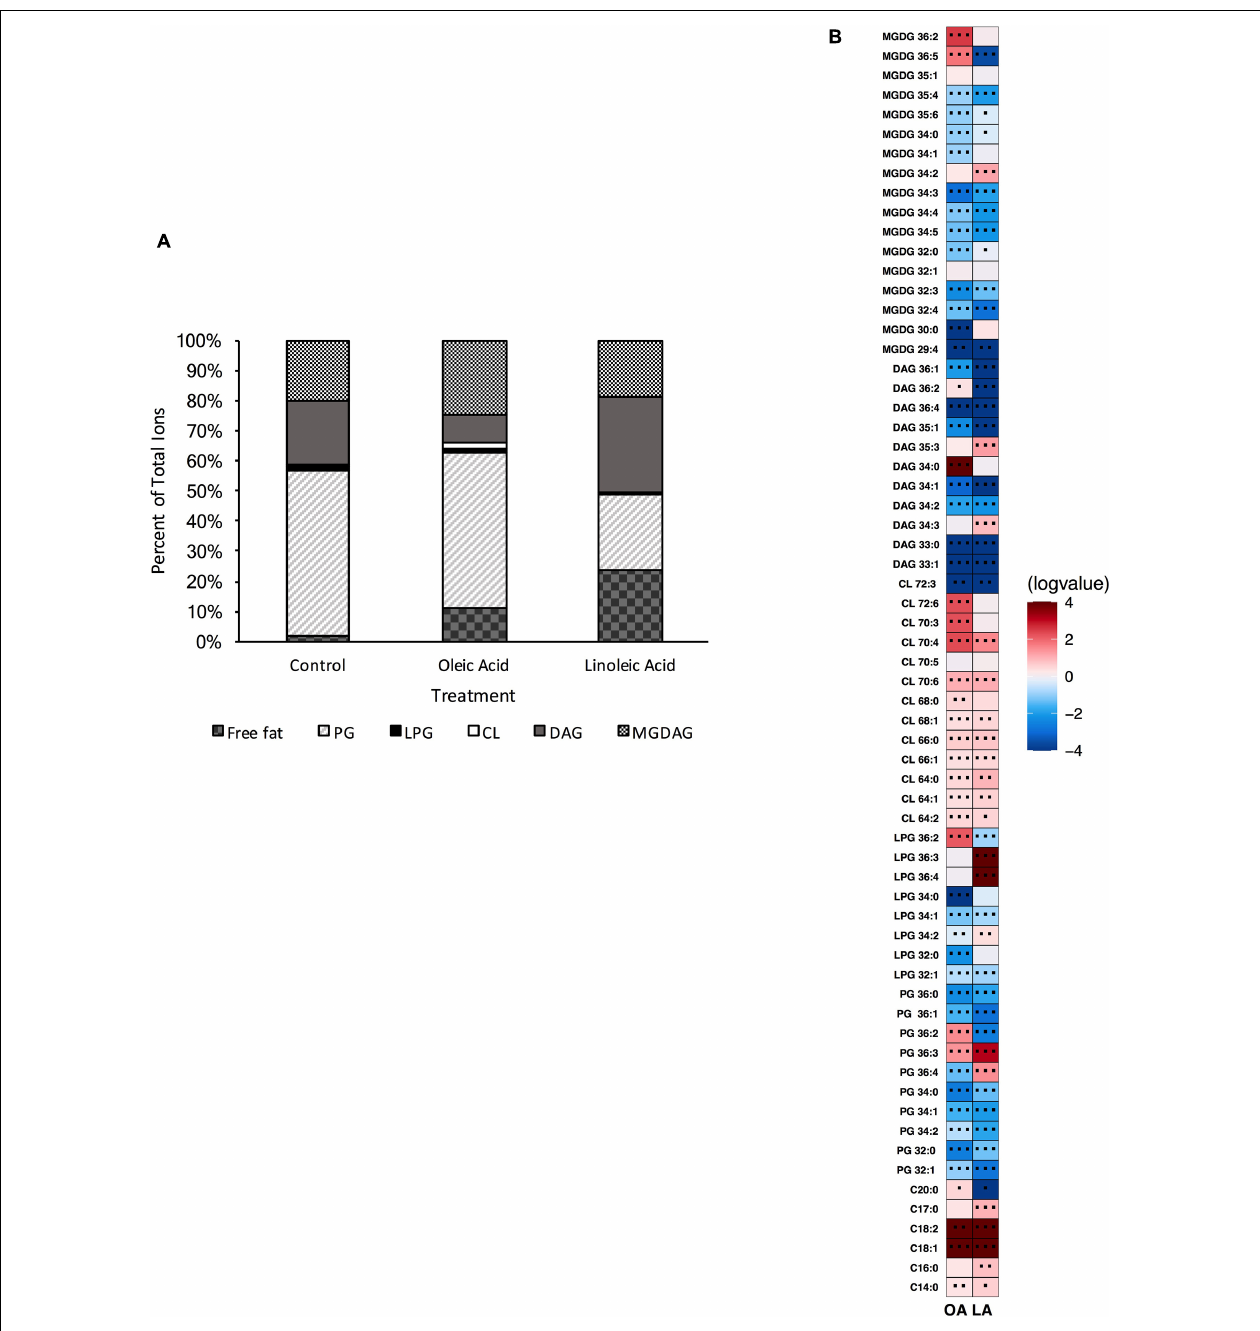
FIGURE 3 | OG1RF lacking (cid:49) cls2 can still produce cardiolipin and alter its lipid composition upon exposure to host fatty acids. (A) Percent totals of lipid species for (cid:49) cls2 in solvent control: free fatty acids (1.9%), PG (55.1%), L-PG (1.0%), CL (0.7%), DAG (21.2%), and MGDG (20.1%), oleic acid: free fatty acids (11.1%), PG (51.6%), L-PG (1.2%), CL 2.1%), DAG (9.4%), and MGDG (24.6%), linoleic acid: free fatty acids (35.5%), PG (35.5%), L-PG (1.9%), CL (2.6%), DAG (4.1%), and MGDG (20.4%). Species were normalized to OD 600 nm . (B) Heat-map of fold changes (cid:49) cls2 upon fatty acid supplementation vs. solvent control; OA, oleic acid supplementation; LA, linoleic acid supplementation. Shown are the average fold changes of those detected lipid species above limit of detection for n = 5 samples. * P = 0.1–0.05; ** P = 0.05–0.01; *** P < 0.01.